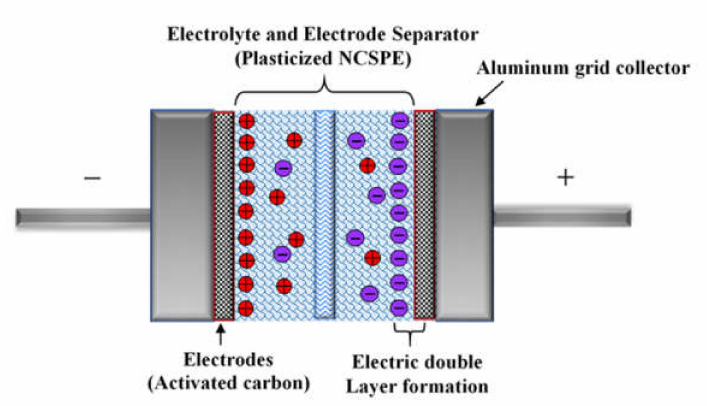
Figure 11. Schematic diagram of charge accumulation in an ideal electric double-layer capacitor